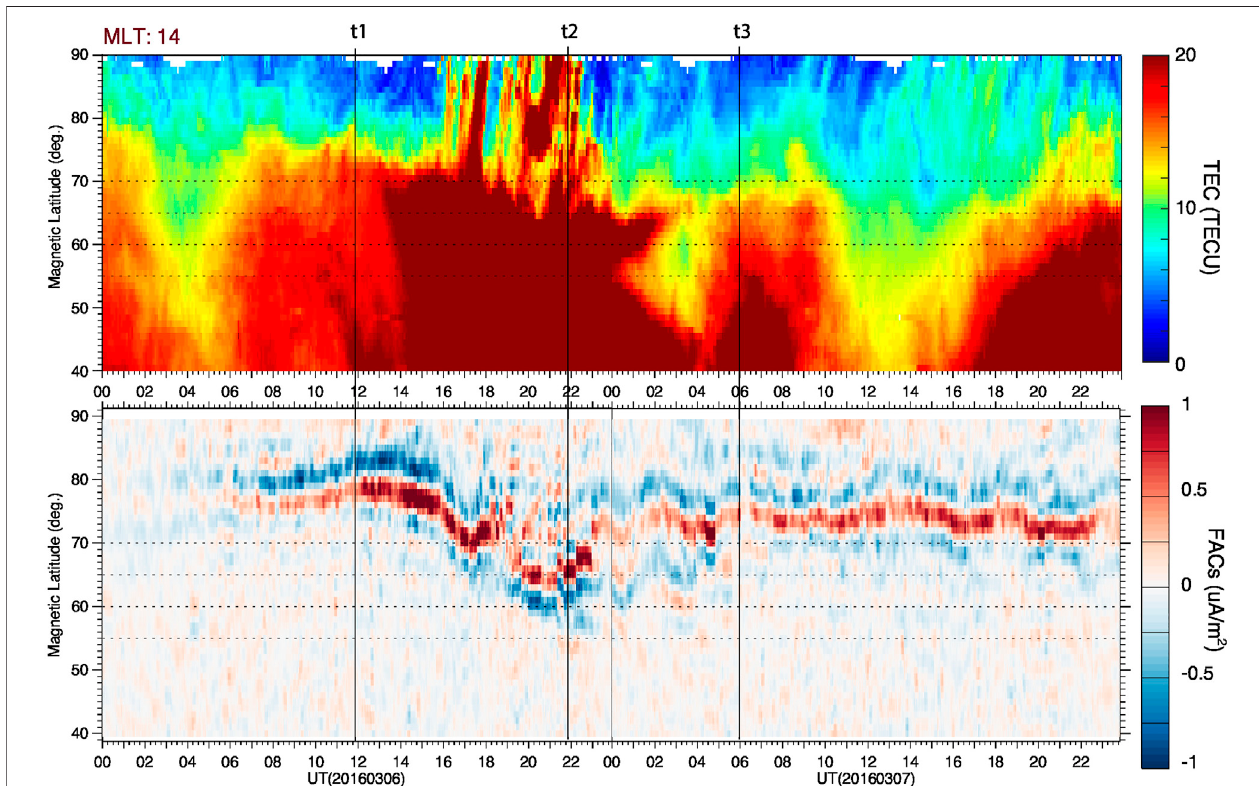
FIGURE 3 | Time series of TEC and FACs at 14 MLT are shown for March 06 – 07 storm. Upward FACs are positive and in red colors, while downward FACs are negative and in blue